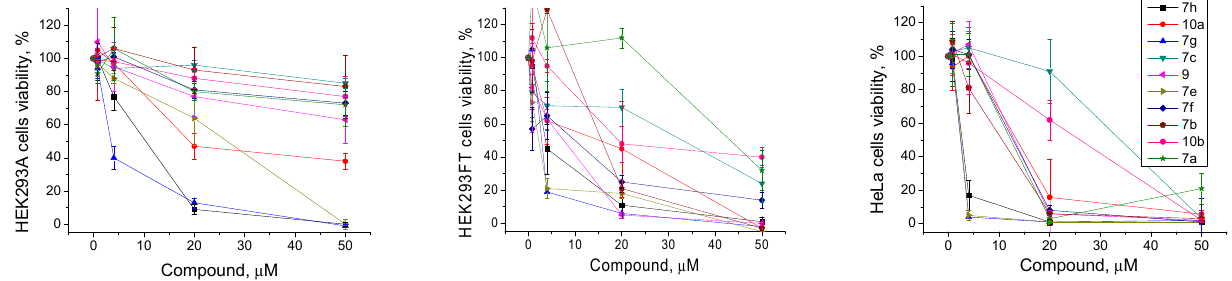
Figure 4. TDP1 inhibitors’ intrinsic cytotoxicity on HEK293A, HEK293FT, and HeLa cells, and the dose-dependent action of the most effective compounds. The values were normalized on the control wells with the cells in 1% DMSO.